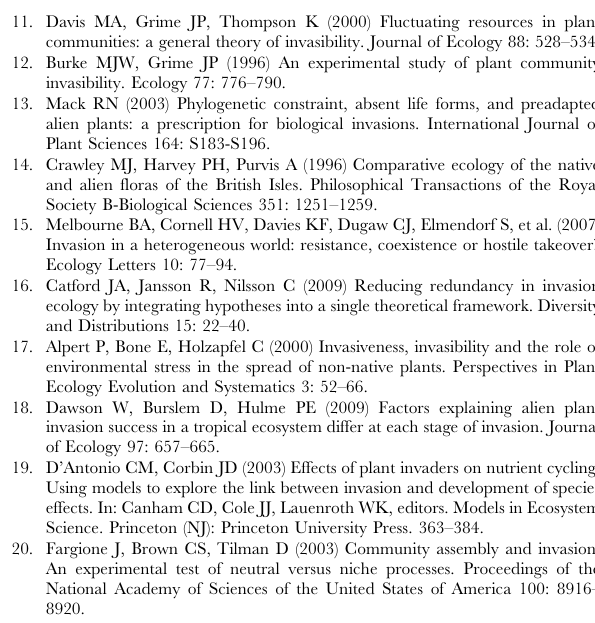
Figure S1 Allometric relationships between previous-year stem mass and current year leaf (left) and inflorescence (right) mass in A. altissima (data of 2011). Different symbols and lines represent different sexes. The Wald statistic indicates a significant difference in line elevation. No significant difference was found between slopes. Figure S2 Left- Allometric relationships between previous-year stem mass and current year stem (A), leaf (C), inflorescence (E) and infrutescence (G) mass (note the log-scale of both axes). The Likelihood Ratio Statistic (LRS) comparing slopes across species and its significance is shown in each chart. When slopes were equal, we also show results for the Wald satistics (WS) comparing elevation and shift along a common slope. Right- current-year stem (B), leaf (D), inflorescence (F) and infrutescence (H) mass per unit of previous-year stem mass. Different letters across species indicate significant differences (Linear mixed model, species and